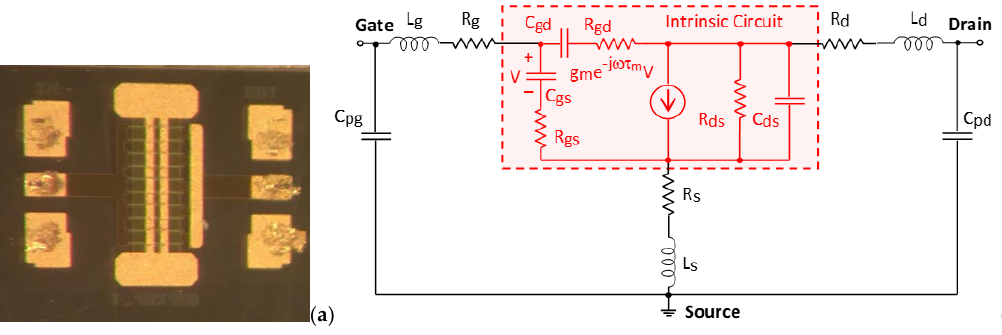
Figure 1. ( a ) Photograph of the studied GaN HEMT and ( b ) its small-signal equivalent circuit.